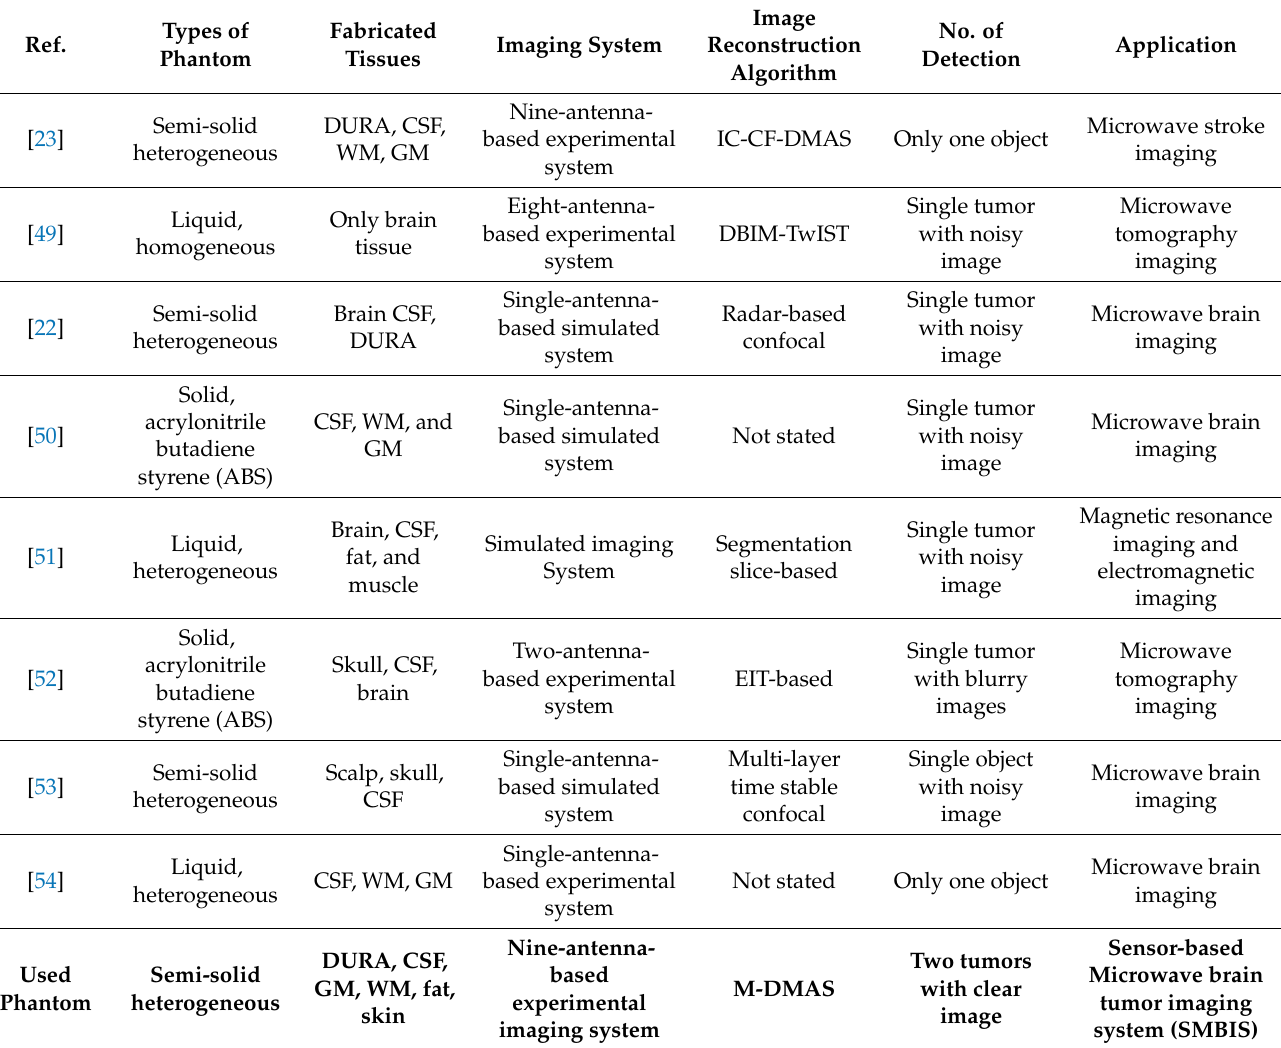
Table 2. Comparison of the implemented system in bold with other imaging system and algorithms.